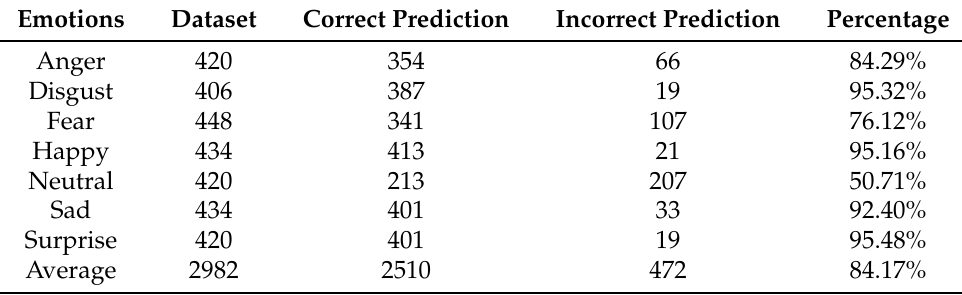
Table 19. Cross dataset testing result of Test Model 1 after 10